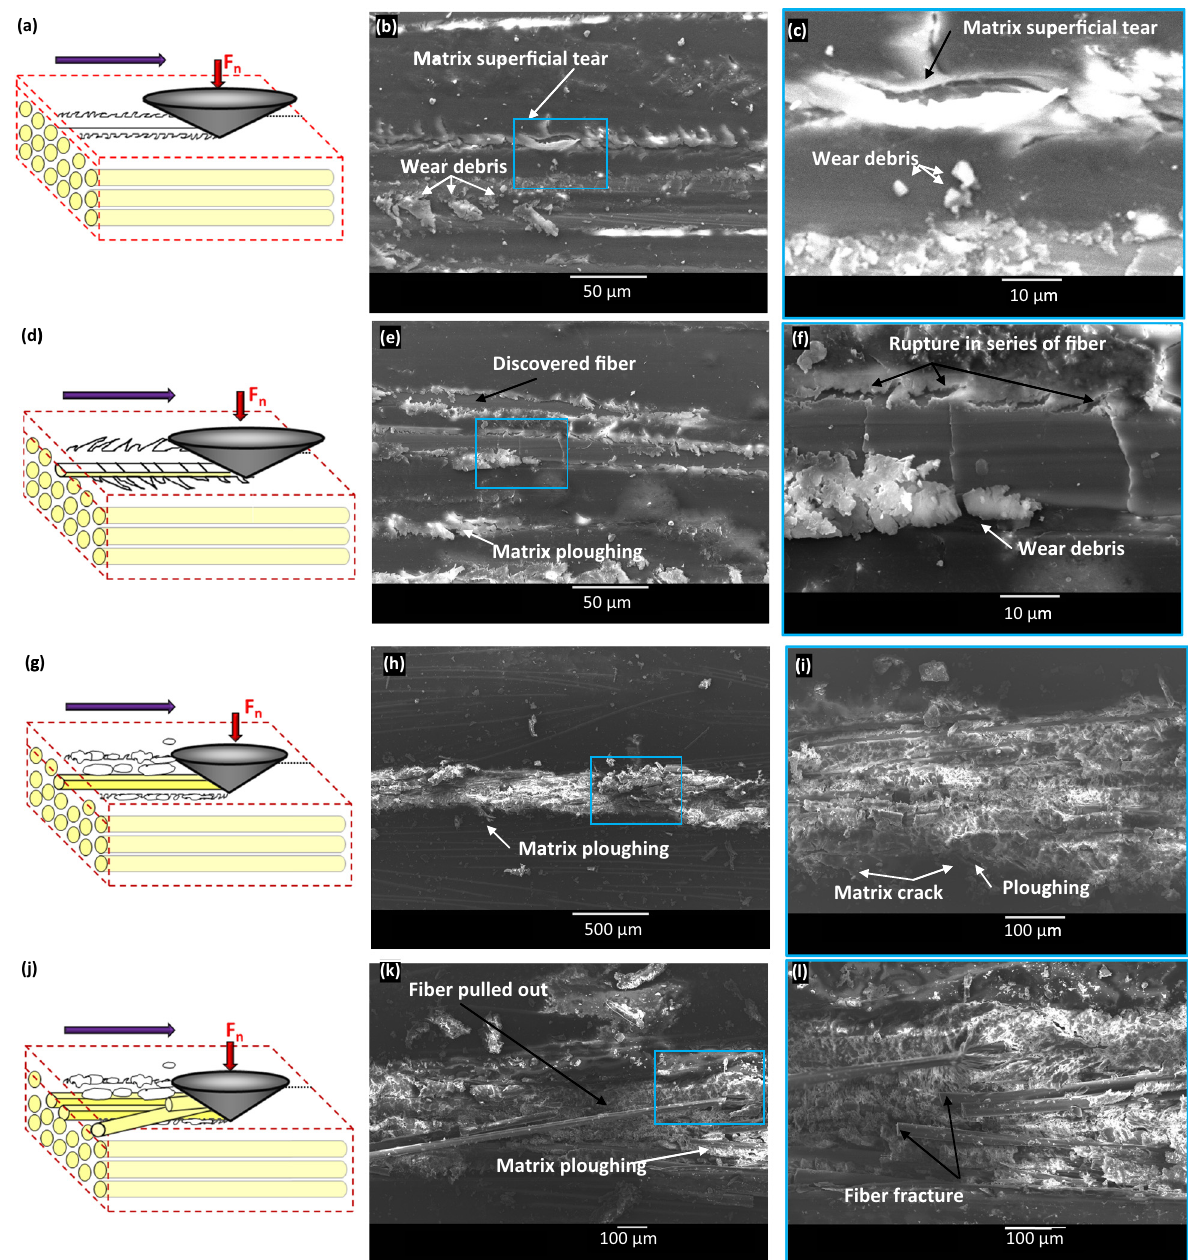
Figure 2: Wear scenarios and SEM micrographs emphasizing the SST // wear mechanisms. ( a – c ) θ = 10° − F n = 20 N, ( d – f ) θ = 10° − F n = 50 N, ( g – i ) θ = 30° − F = 20 N, and ( j – l ) θ = 30° − F = 50 n n